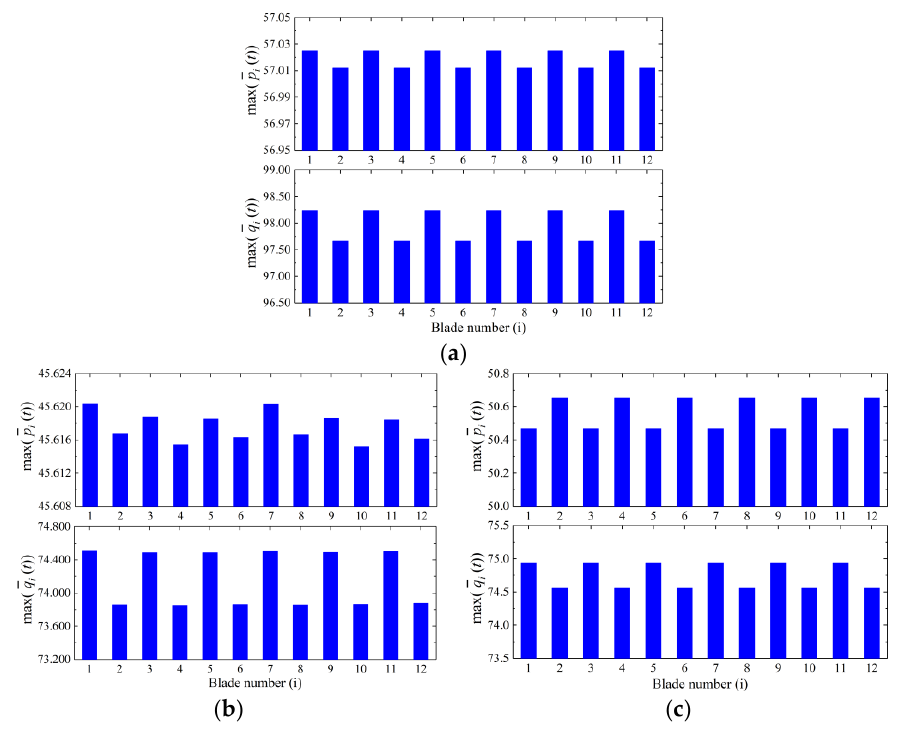
Figure 8. Maximum displacements of the blades ( a ) General case with Ω = 6000 r/min; ( b ) The beat case with Ω = 4750 r/min and ( c ) Contact- and friction free with Ω = 4750